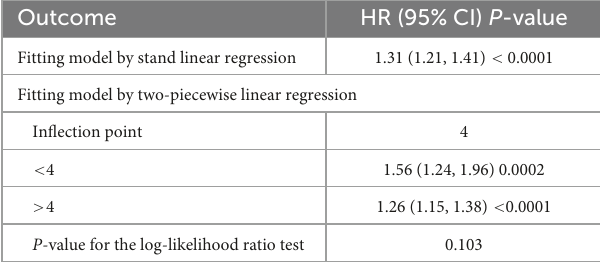
TABLE 4 Non-linearity addressing of aCCI and mortality.